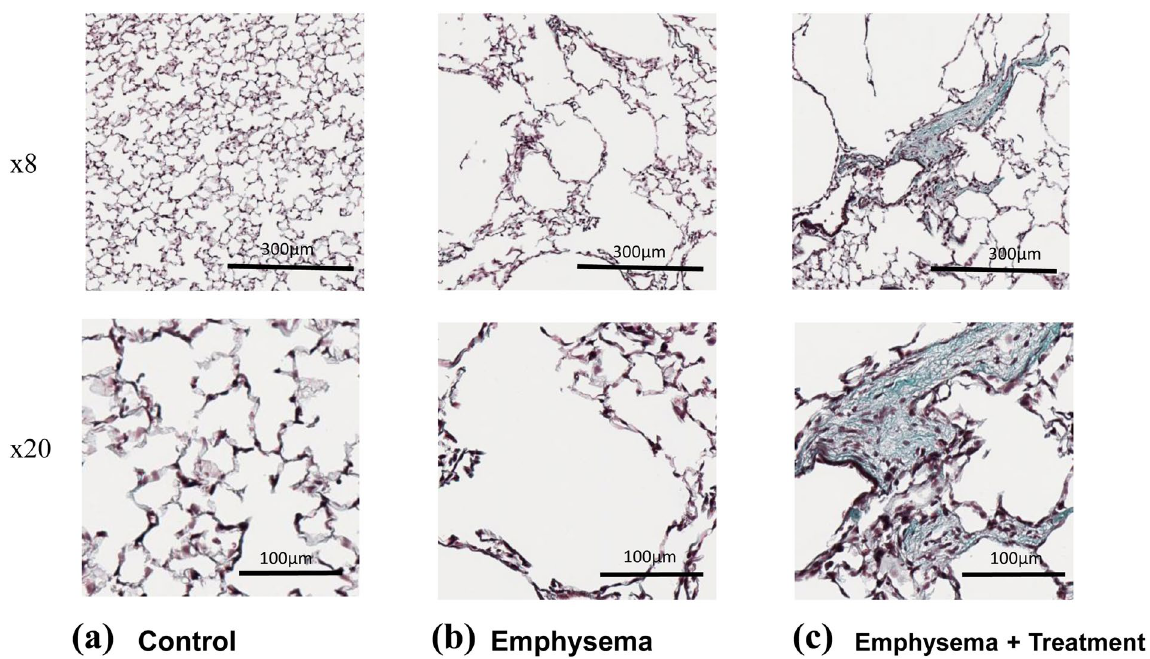
Figure 7. Representative Masson’s trichrome staining photomicrographs showing the morphology of lung. ( a ) Control: saline (100 µl), ( b ) Emphysema: PPE (1.5U/100 g body weight), and ( c ) Emphysema + Treatment: PPE + RF (1.5U/100 g body weight + 0.5 W/g) at day 35. Upper panels ×8 magnification (scale bar 300 µm). Lower panels ×20 magnification (scale bar 100 µm). Clear emphysema was observed in emphysema group and fibrosis was induced by the RF treatment as seen in the emphysema + treatment